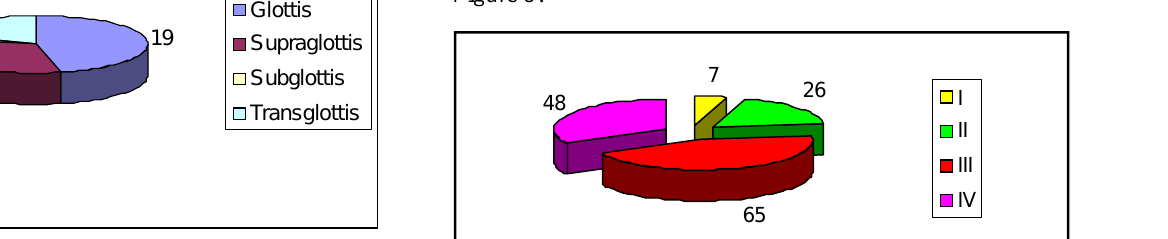
Fig.1 : Malignancies of Larynx